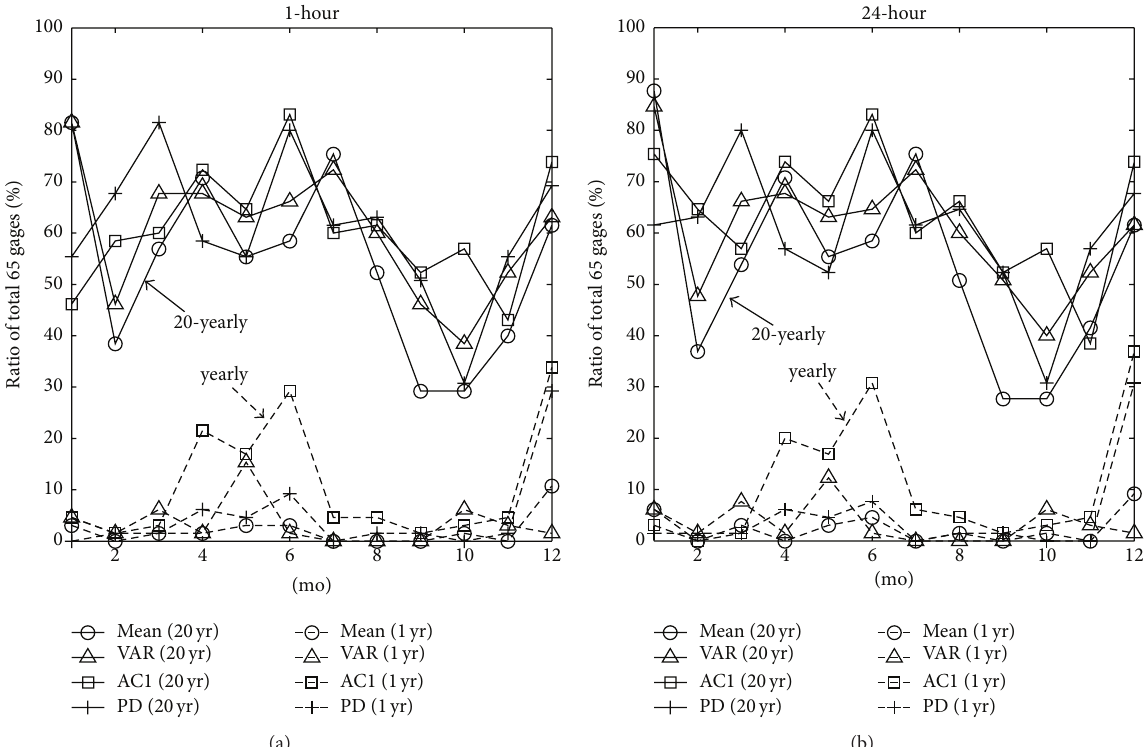
Figure 6: The result of the Mann-Kendall test on yearly and 20-yearly precipitation statistics. One-hour (a) and 24-hour (b) accumulation level are shown,